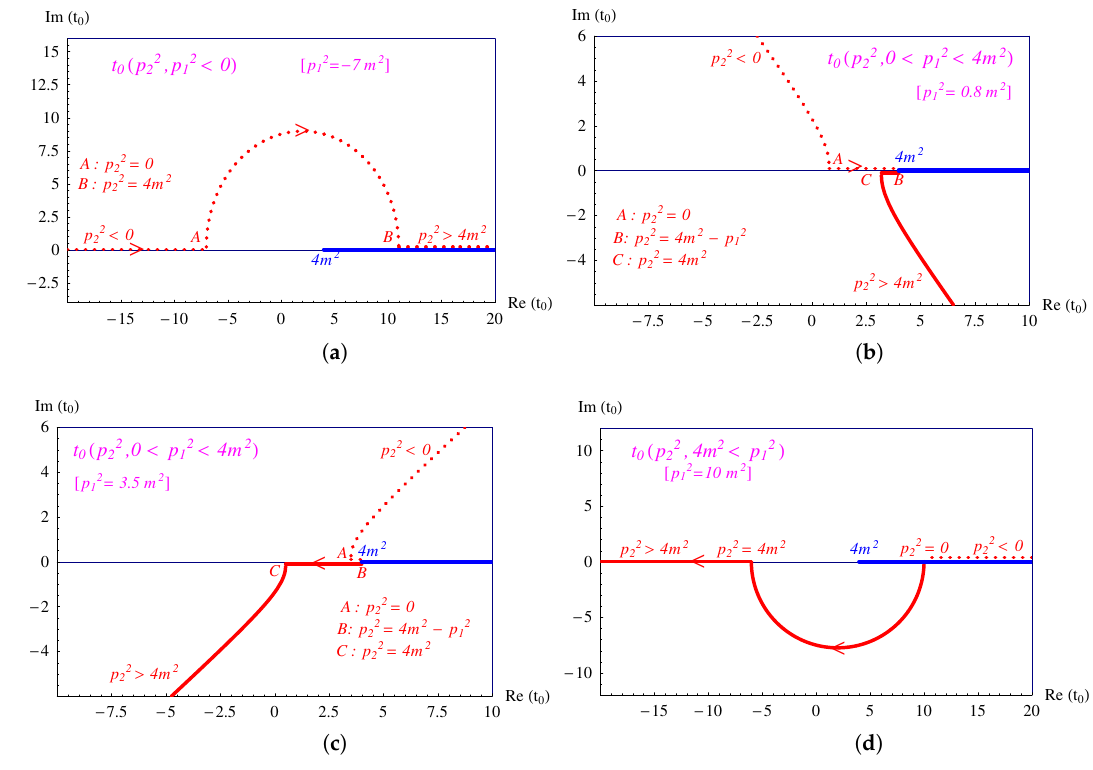
) ≡ t − ( p 2 ) vs p 2 Figure 3. The trajectory of the branch point t 0 ( p 2 , p 2 , p 2 at a fixed value of p 2 in 2 2 2 1 1 1 0 ≤ 0 [ p 2 = − 7 m 2 ]: the (dashed line) trajectory lies on the second sheet, the complex- q 2 plane: ( a ) p 2 1 1 < 4 m 2 [( b ): p 2 = 0.8 m 2 , ( c ): p 2 = 3.5 m 2 ]: and does not appear on the physical sheet; ( b , c ) 0 < p 2 1 1 1 > 4 m 2 − p 2 the trajectory first lies on the second sheet (dashed line), but for p 2 moves around the 2 1 normal-cut branch point through the normal cut onto the physical sheet (solid line); ( d ) 4 m 2 < p 2 1 = 10 m 2 ]: for p 2 < 0, the trajectory runs on the unphysical sheet, but, at p 2 = 0, it comes up to the [ p 2 2 2 1 > 0 travels over this physical sheet. As soon as the branch point t ( p 2 ) physical sheet and for p 2 , p 2 0 2 2 1 appears on the physical sheet, the q 2 -integration contour should be modified such that it embraces ) . The normal cut along the real axis for q 2 > 4 m 2 is both the normal cut and the branch point t 0 ( p 2 , p 2 2 1 depicted in